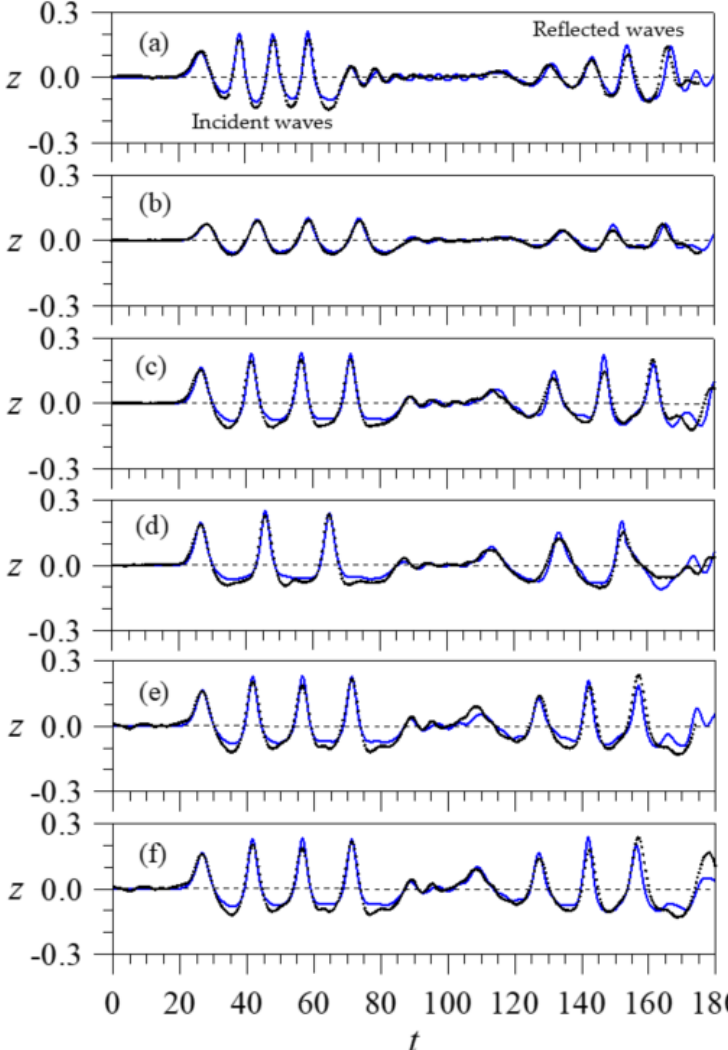
Figure 3. Comparisons of time variations of incident and reflected waves between the present CAN model solutions (solid-blue lines) and experimental data (black-dotted lines) for cnoidal waves en- countering with a partially immersed body with various input parameters, ( a ) α = 0.3, λ = 10, h 1 = 0.2, L = 4, (RMSE = 0.0211), ( b ) α = 0.15, λ = 15, h 1 = 0.2, L = 4, (RMSE = 0.00856), ( c ) α = 0.3, λ = 15, h 1 = 0.5, L = 4, (RMSE = 0.02), ( d ) α = 0.3, λ = 20, h 1 = 0.5, L = 4, (RMSE = 0.0683), ( e ) α = 0.3, λ = 15, h 1 = 0.5, L = 6, (RMSE = 0.0265), and ( f ) α = 0.3, λ = 15, h 1 = 0.5, L = 10, (RMSE = 0.0252). Various parameters that affect the outcomes of the reflected and transmitted waves were tested. Waves with wave heights ranging from α = 0.15 to 0.3 and wave lengths of λ = 10, 15, and 20 were generated to examine the effect of wave conditions. The effects